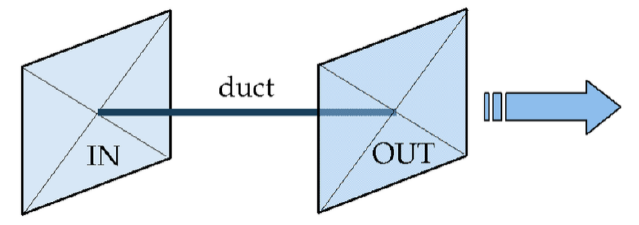
Figure 6. Fan model in FDS.